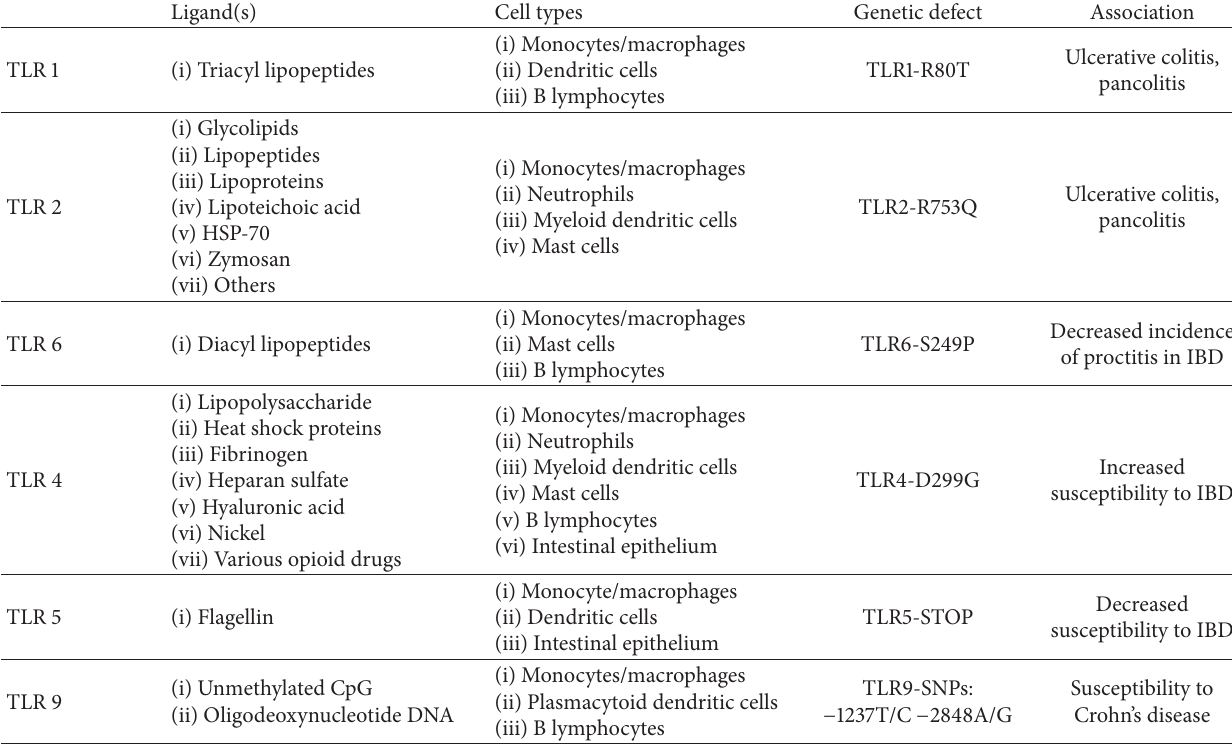
Table 1: Human TLRs: an overview on their